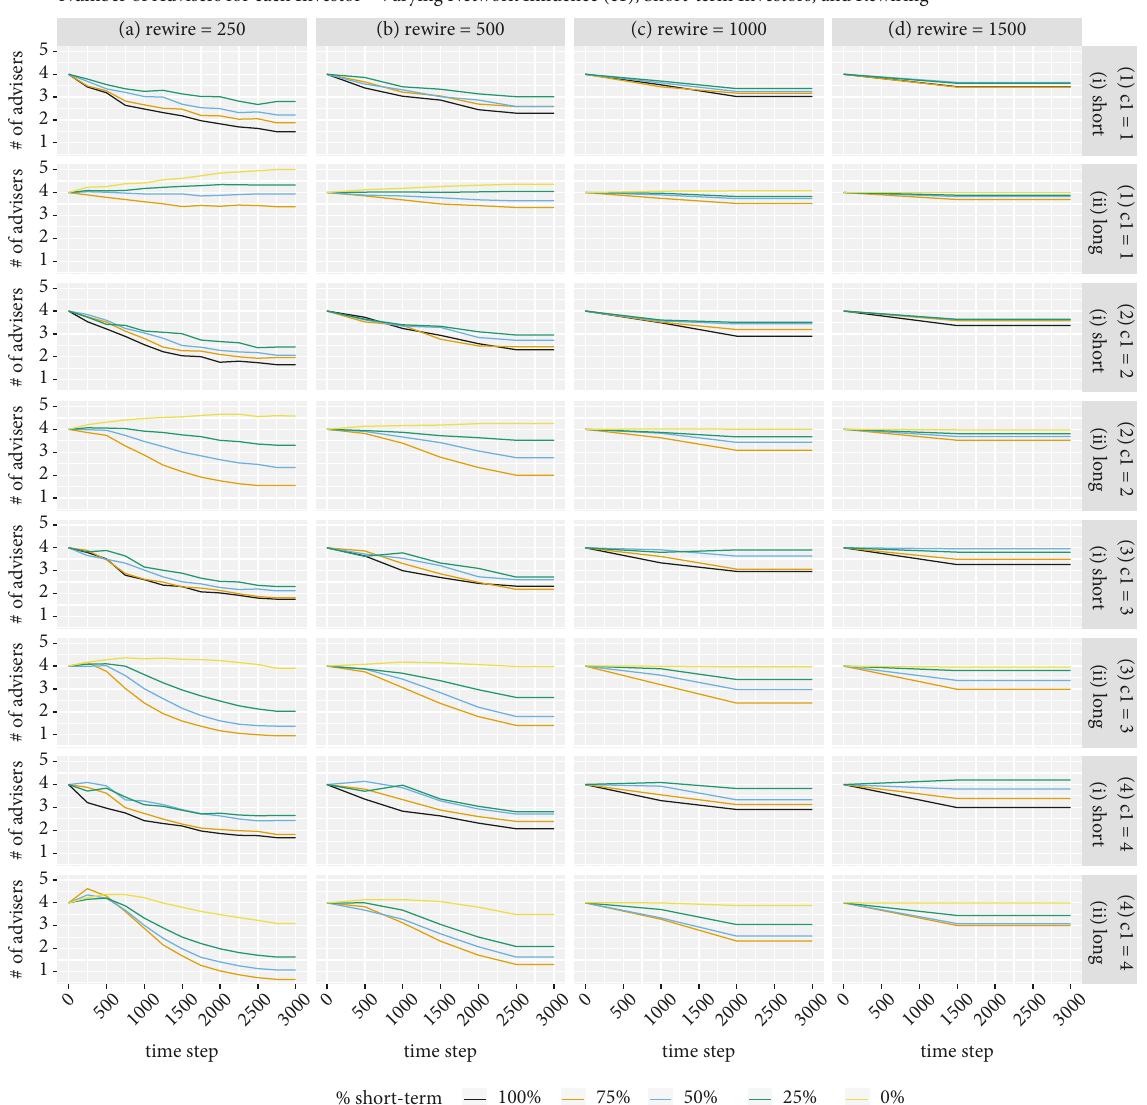
Figure 8: The development of the median number of advisers the investor population maintains. The investor subclasses split the facets and along with the other settings highlight the different behavior of the two classes, with the lines representing the